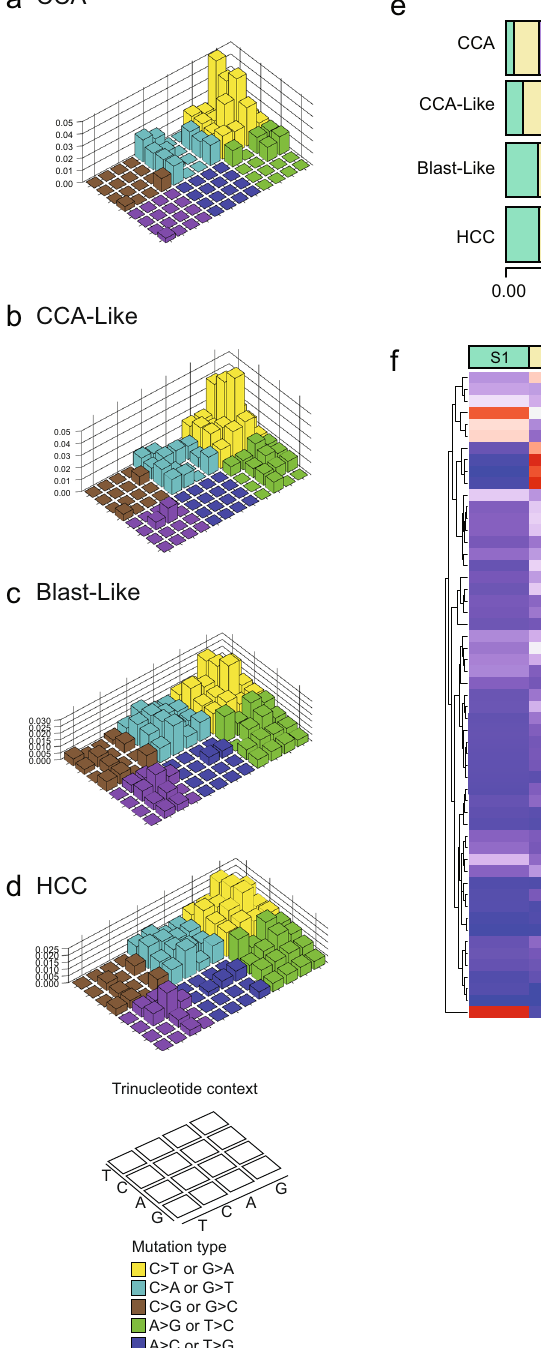
Fig. 3 Mutational signatures of CCA and HCC reveal cross-class similarity. a − d The median frequency of each single nucleotide variant (SNV) per class was calculated and plotted by preceding and succeeding base in a Lego plot (key, bottom left). Base substitutions are divided into six categories to represent the six possible base changes. Substitutions are further divided by the 16 possible fl anking nucleotides surrounding the mutated base as listed in the trinucleotide context legend. e The R package SomaticSignatures was used to identify de novo mutational signatures. Signature contribution across samples is aggregated by class and the median contribution of each signature to the tumor classes is shown. f Cosine similarity between COSMIC v3 mutational signatures and each of the de novo signatures were computed. The COSMIC signatures are clustered by cosine similarity and ordered by signature class (S1 − S6). The color key indicates the degree of